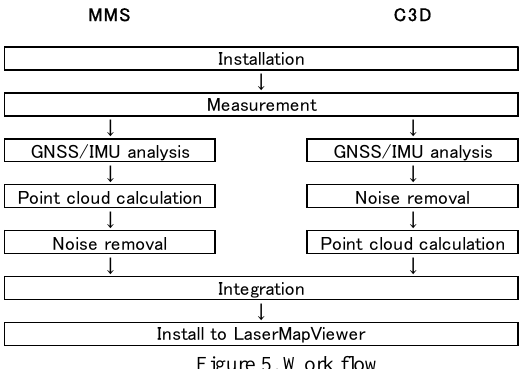
Figure 5. Work flow